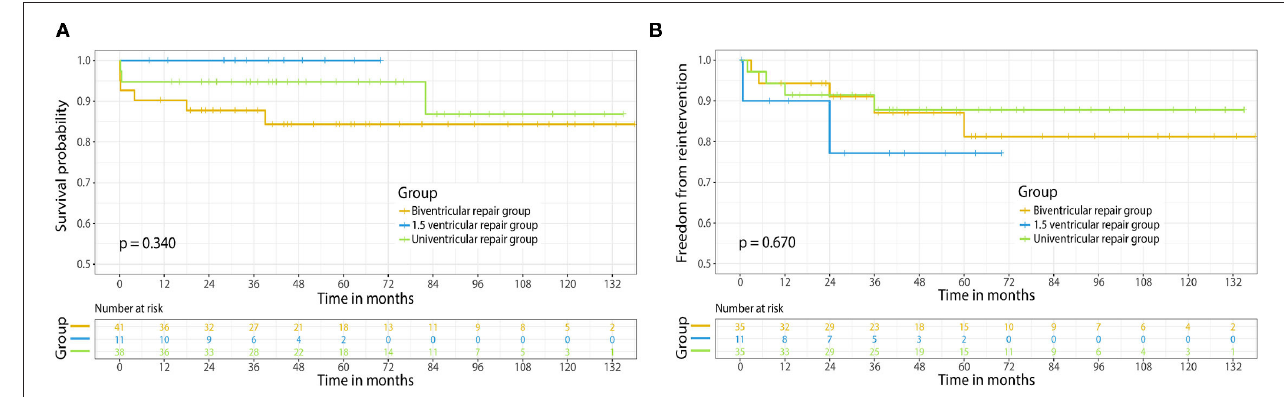
FIGURE 2 | (A) Kaplan-Meier survival curve of different surgical strategies for ccTGA. (B) Freedom from reoperation of different surgical strategies for ccTGA. Numbers of patients at risk are indicated in the rectangle.